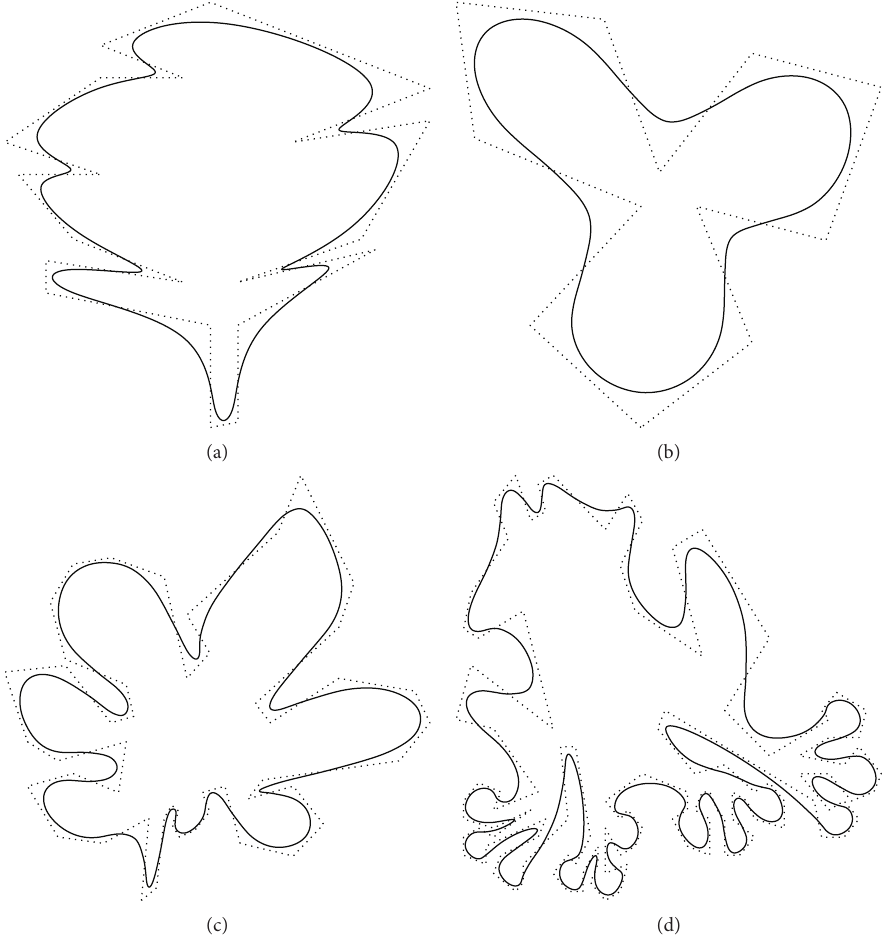
Figure 3: (a–d) Limit curves for close polygons produced by the scheme corresponding to S